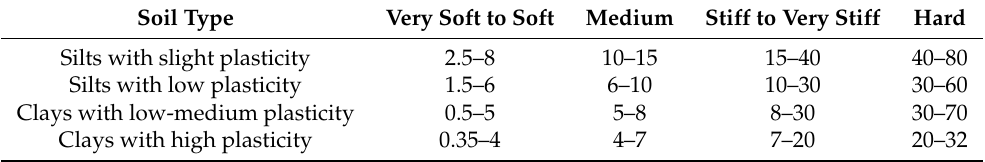
Table 3. Typical values of Young’s modulus for cohesive material (MPa)